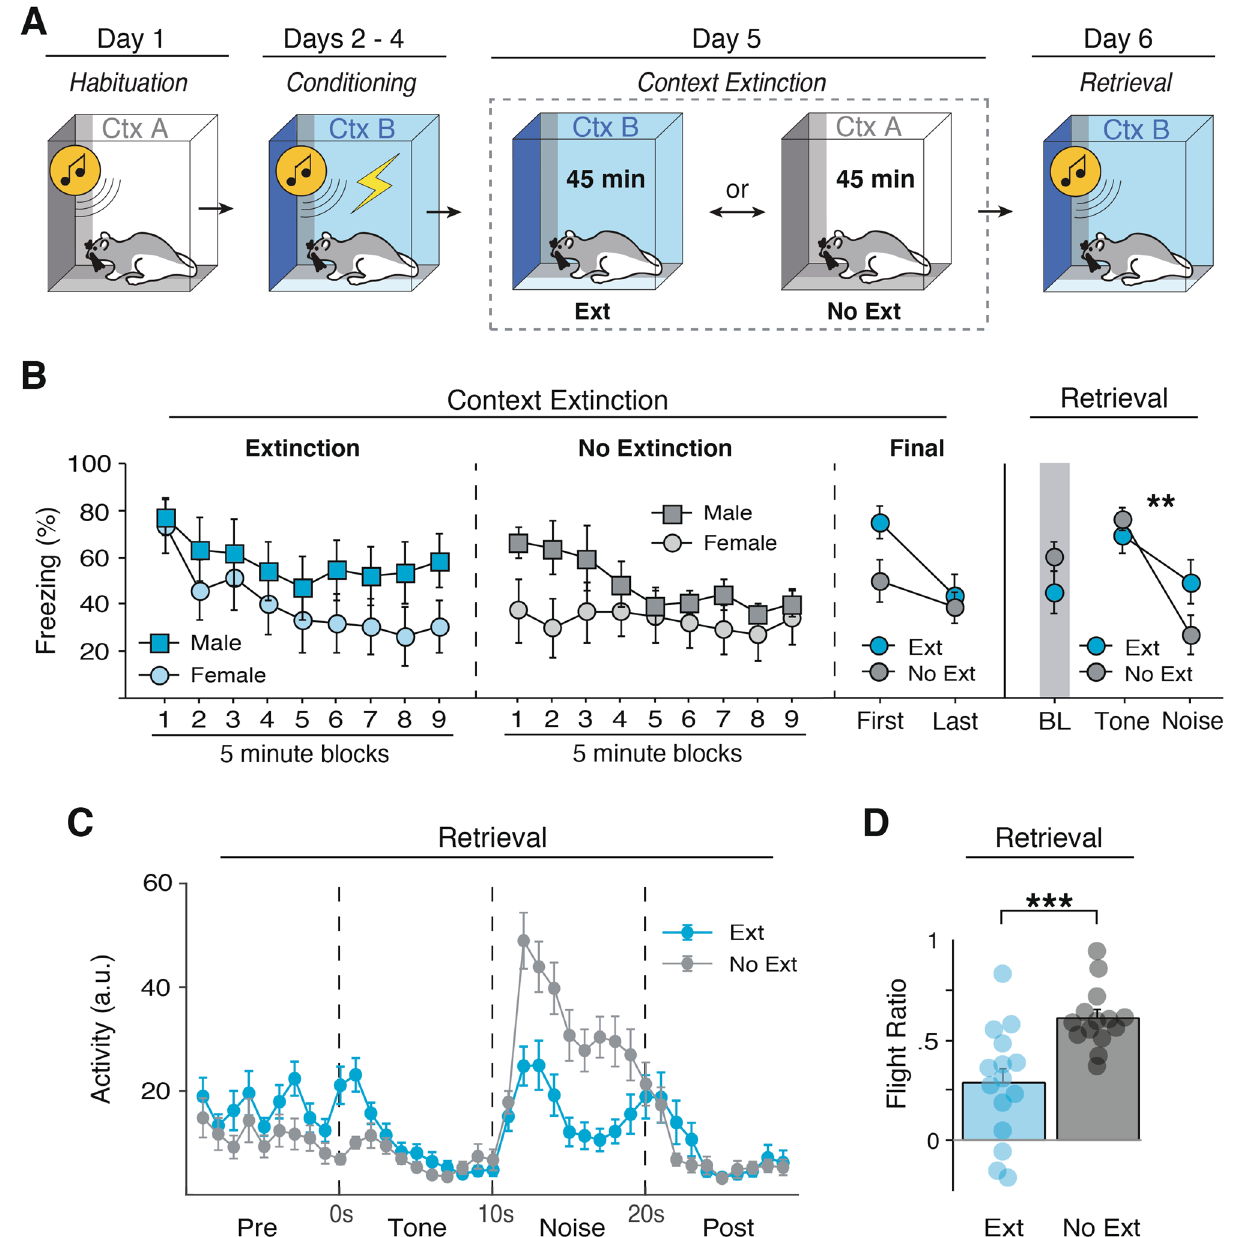
Figure 3. Extinguishing contextual fear reduces flight-like behavior. ( A ) Behavioral design. ( B ) Freezing data across the first extinction (Ext) or no-extinction (No-Ext) session comparing males and females averaged into 5-min blocks. Rats that underwent context extinction froze at high levels at the beginning of extinction which reduced by the end of extinction. Rats that did not undergo extinction did not show a reduction in freezing from the first to last block of context exposure. In addition, female Ext rats froze less to the conditioning context at late time points, whereas male No Ext rats showed greater generalization in the neutral context. ( C ) Ext animals did not show a significant reduction in baseline freezing, but did show a reduced flight response as shown by the reduced flight ratio. ( D ) Averaged activity data showing that Ext animals showed reduced activity during the white noise stimulus compared to No-Ext animals. All data are represented as mean ± SEM pooled across sex [EXT ( n = 15; 7 male & 8 female); No-EXT ( n = 14; 6 male and 8 female)]; *, **, and *** denote p < 0.05, p < 0.01, and p < 0.001,